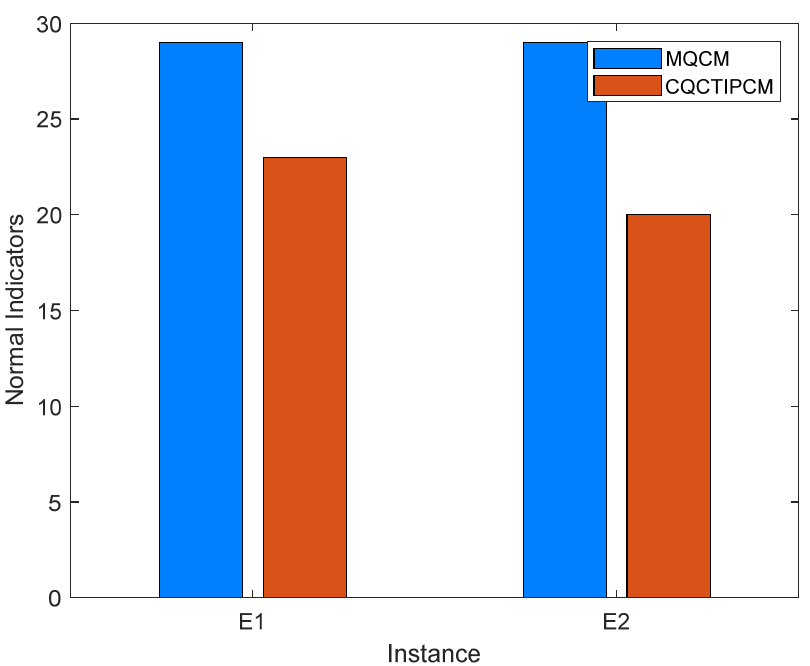
Figure 11. Comparison results of the number of abnormal indexes before and after quality control.